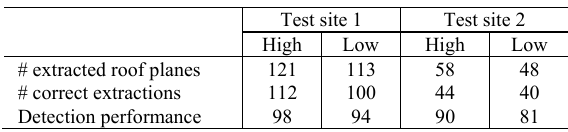
Table 2: Summary of roof plane extraction